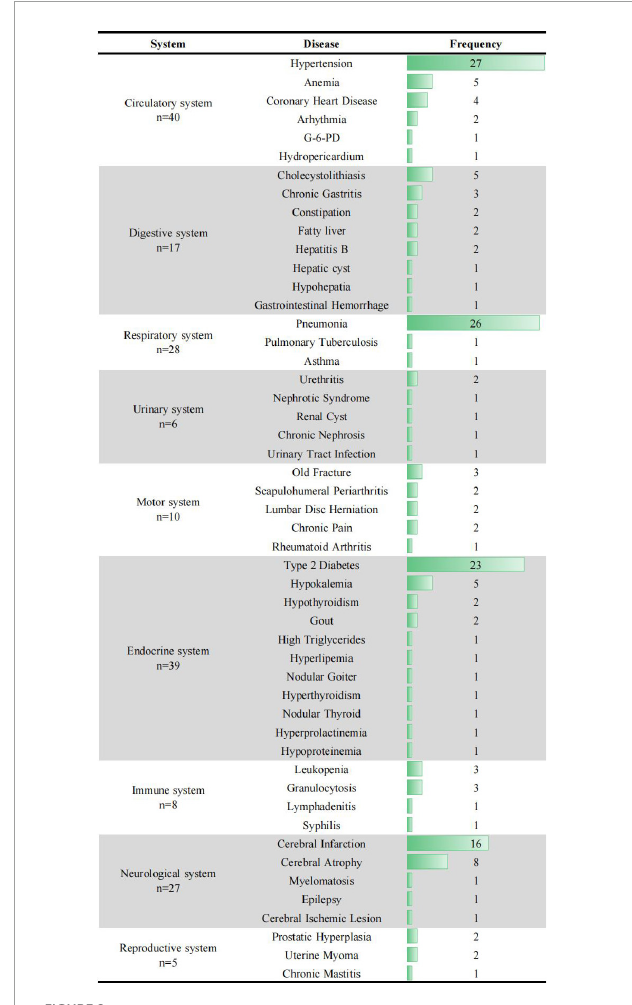
FIGURE2 Frequency of diseases in different body